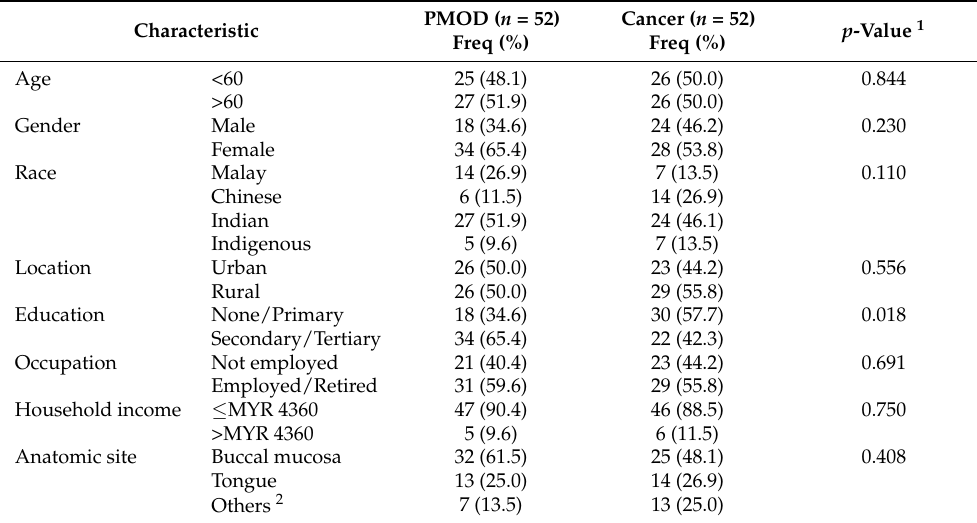
Table 2. Sociodemographic and clinical characteristics of